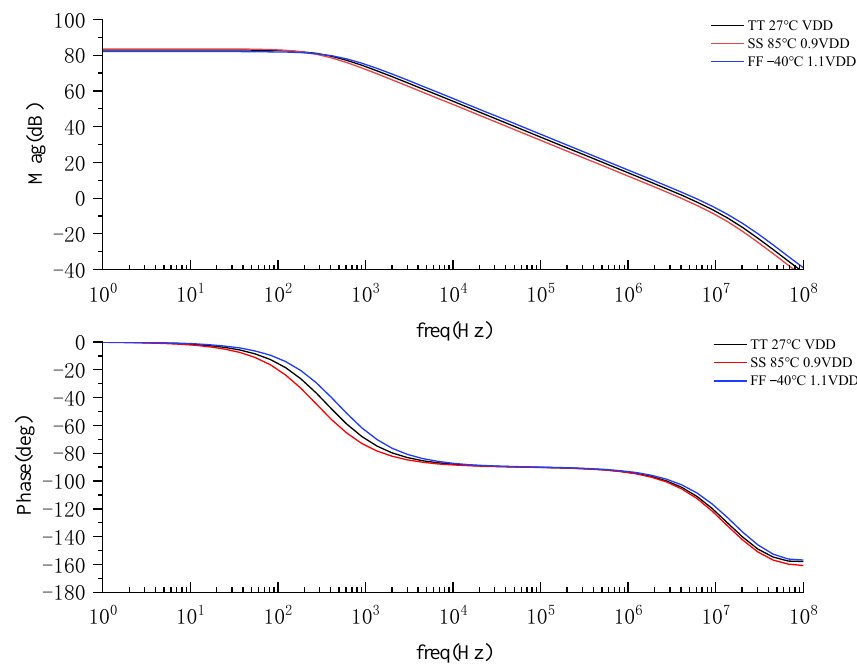
Figure 10. Gain and phase bode diagram of the amplifier in integrated/amplified